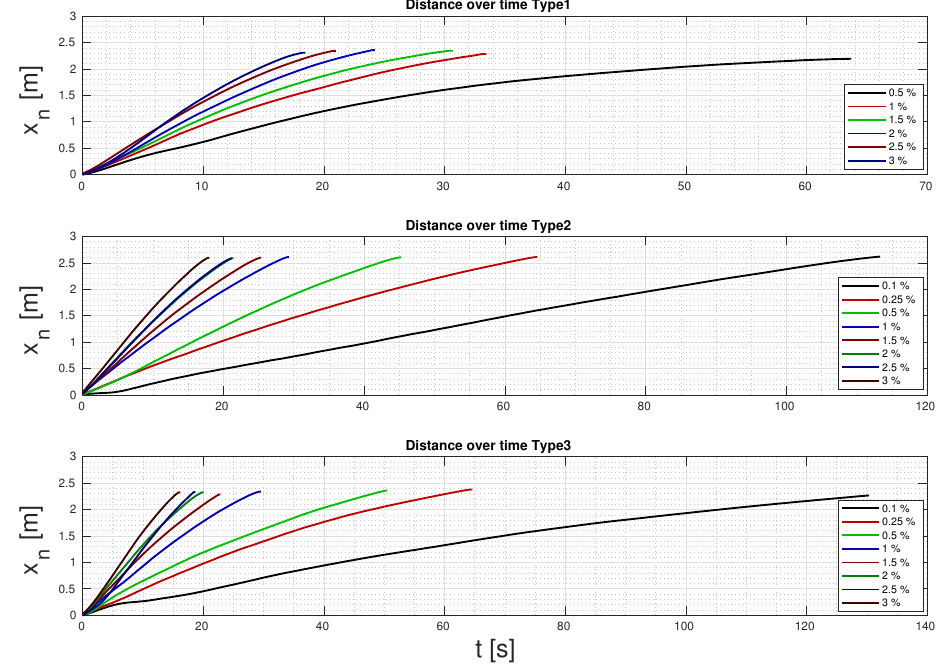
Figure 6. Front position of the turbidity currents x n as a function of the propagation time t .